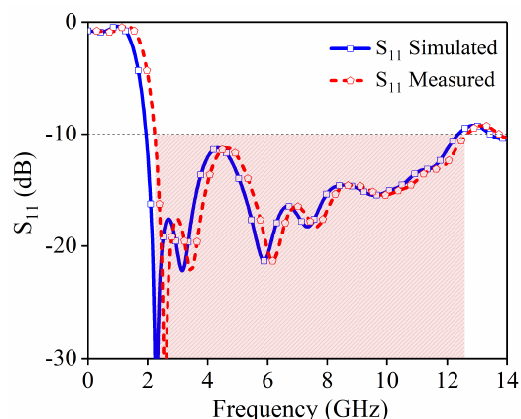
FIGURE 6: Simulated and measured reflection coefficient of the proposed single element.